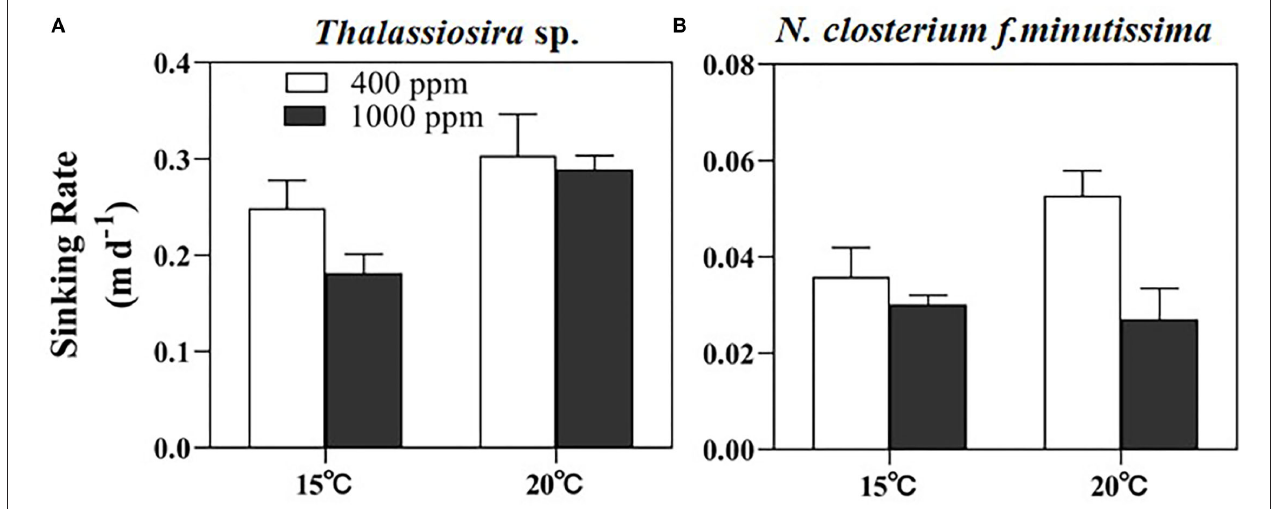
FIGURE 4 | The sinking rate of Thalassiosira sp. (A) and N. closterium f.minutissima (B) under different pCO 2 and temperature conditions. The error bars represent standard deviations of triplicate samples. The letters above the bars denote the statistically significant differences.